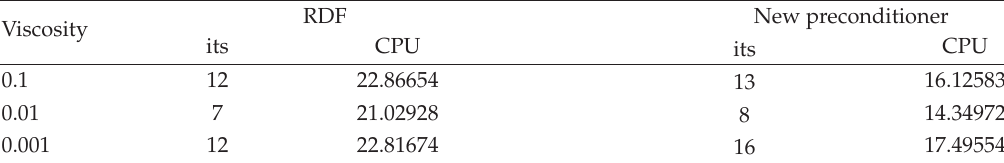
Table 6: Iterations of preconditioned GMRES (cid:4) 30 (cid:5) for generalized Oseen problem (cid:4) Newton, Q2-Q1, 128 × 128 uniform grids (cid:5)